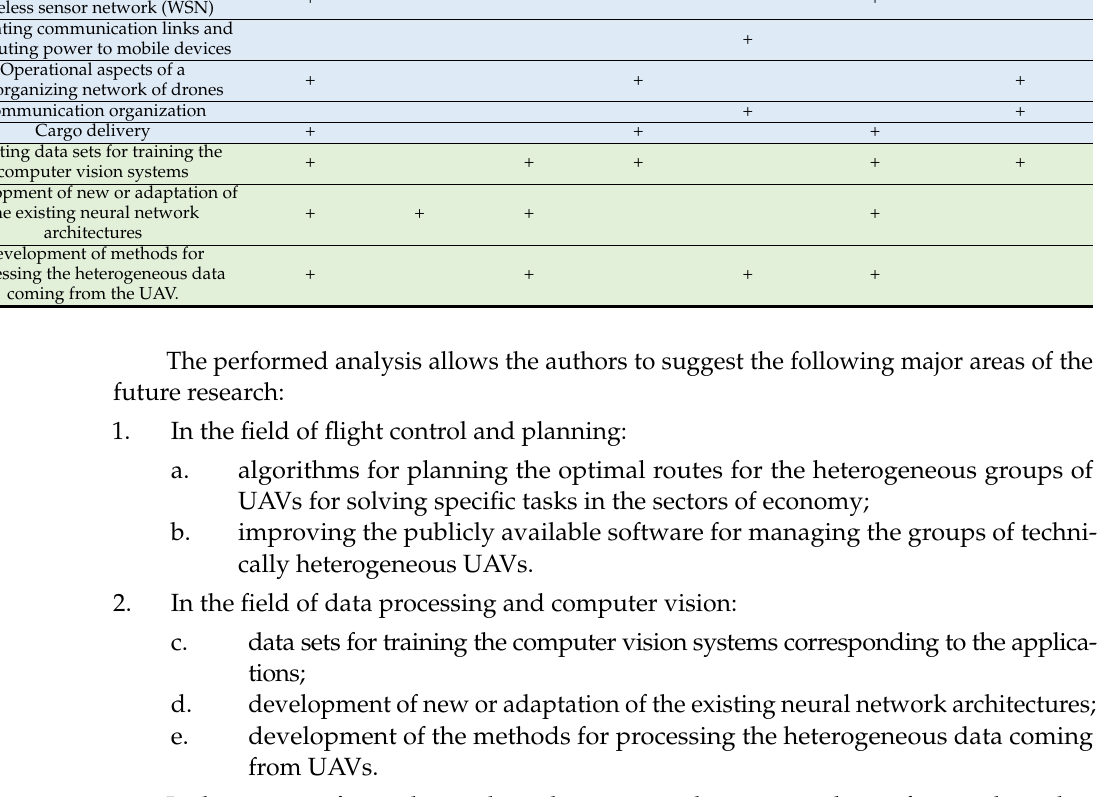
Table 4. Data management and processing tasks, requiring the employment of UAVs in sectors of economy. PA MoEP EoM MoWAL MoHGP MoTES TrM Area coverage + + + + + + Search operations + + + + + + Unmanned aerial vehicle routing problem + + + +